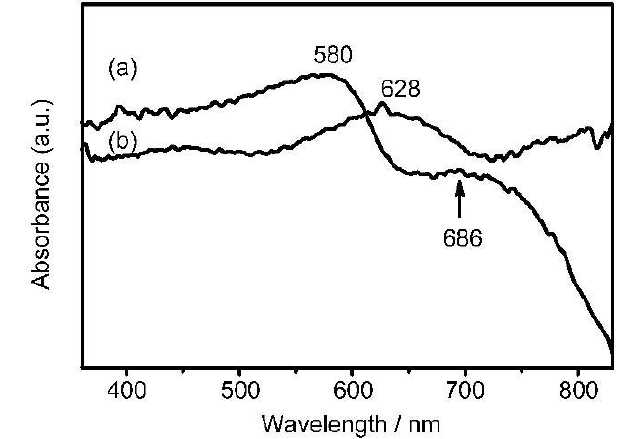
Figure 5. Diffuse reflectance (DR) spectra of ( a ) P(BOCI-Flu) and ( b ) P(I-Flu)